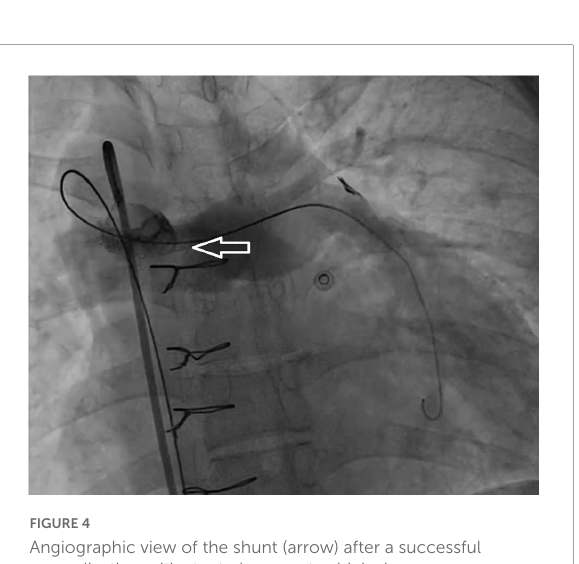
FIGURE4 Angiographic view of the shunt (arrow) after a successful recanalization with stent placement, which shows revascularized shunt with filling of pulmonary artery